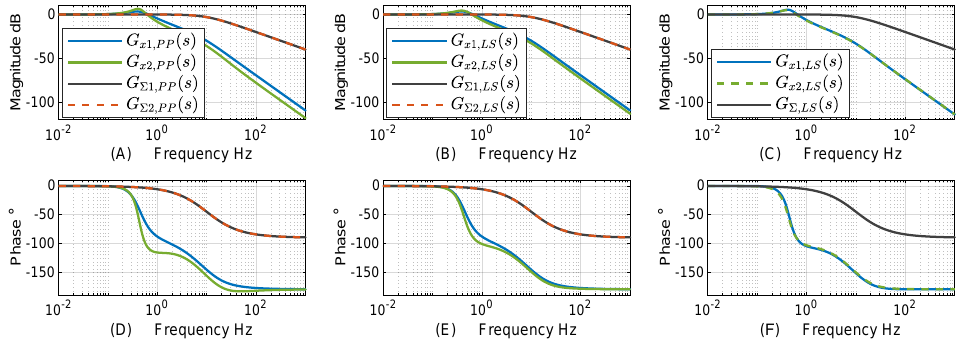
Figure 16. ( A , D ) Closed loop frequency responses for VDN-PP in crane application. ( B , E ) closed loop frequency responses for VDN-L in crane application; ( C , F ) closed loop frequency responses for VDN-LS in crane application. All responses are evaluated at mid-strokes.